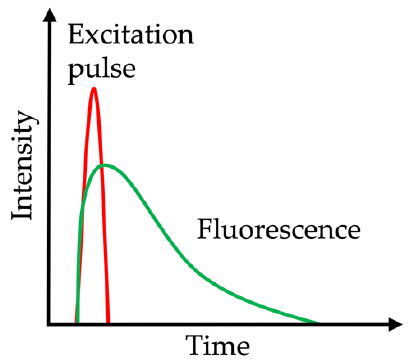
Figure 4. Schematic of the fluorescence lifetime imaging microscopy (FLIM) principle. A short excitation pulse (red) is followed by a longer fluorescence signal (green). FLIM measures the time of the fluorescence signal.